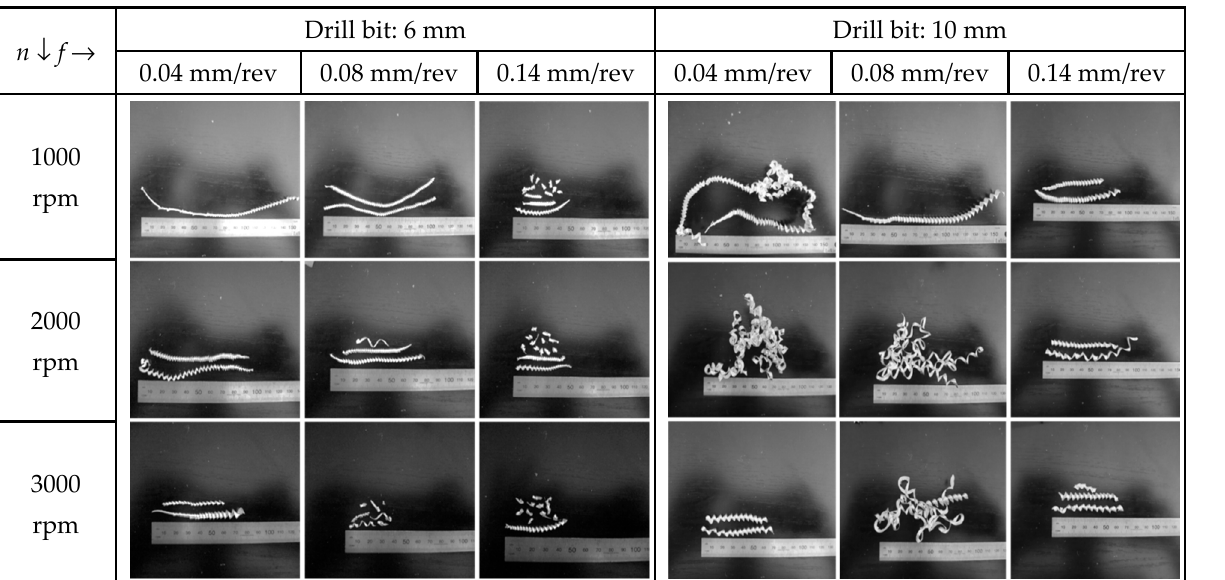
Figure 9. Hole surface damage analysis of AA2024-T3: ( a ) 6 mm drill bit and ( b ) 10 mm drill bit.